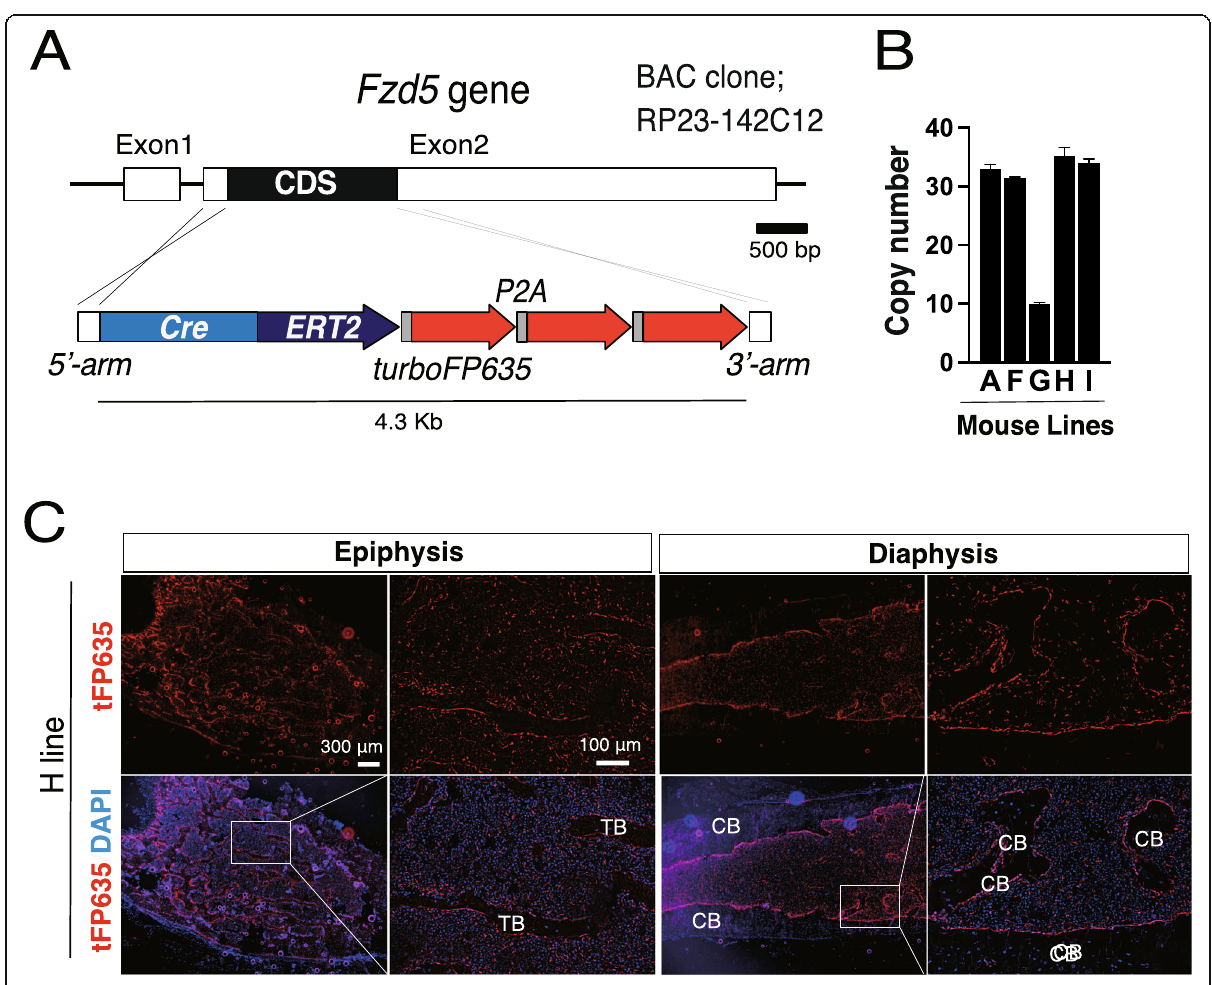
Fig. 1 Generation of Fzd5-CreERT-tFP635 mice using BAC transgenic technology. A The BAC modification strategy to mark Fzd5 -expressing cells by tamoxifen-inducible Cre recombinase (CreERT) and the fluorescent protein, TurboFP635 (tFP635). CreERT and three tandem copies of tFP635 cDNA were linked by P2A and inserted immediately after first ATG of the Fzd5 gene in BAC using a homologous recombination technique. B The copy numbers of BAC DNA in the Fzd5-CreERT-tFP635A , F , G , H , and I lines were assessed by quantitative genomic PCR in triplicate. C tFP635